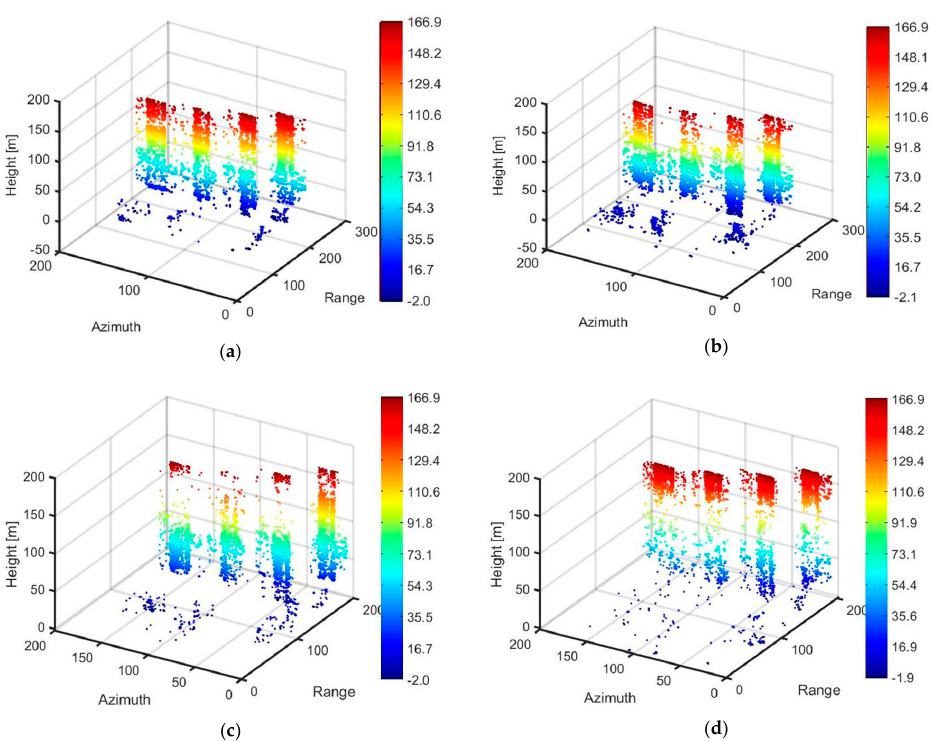
Figure 11. 3D distribution of scatters reconstructed by TWIST for Longzhimeng Changyuan using TerraSAR-X/TanDEM-X orbits ( a ) the corresponding MRA orbits ( b ) random orbit configuration 1 ( c ) and random orbit configuration 2 ( d ), respectively.